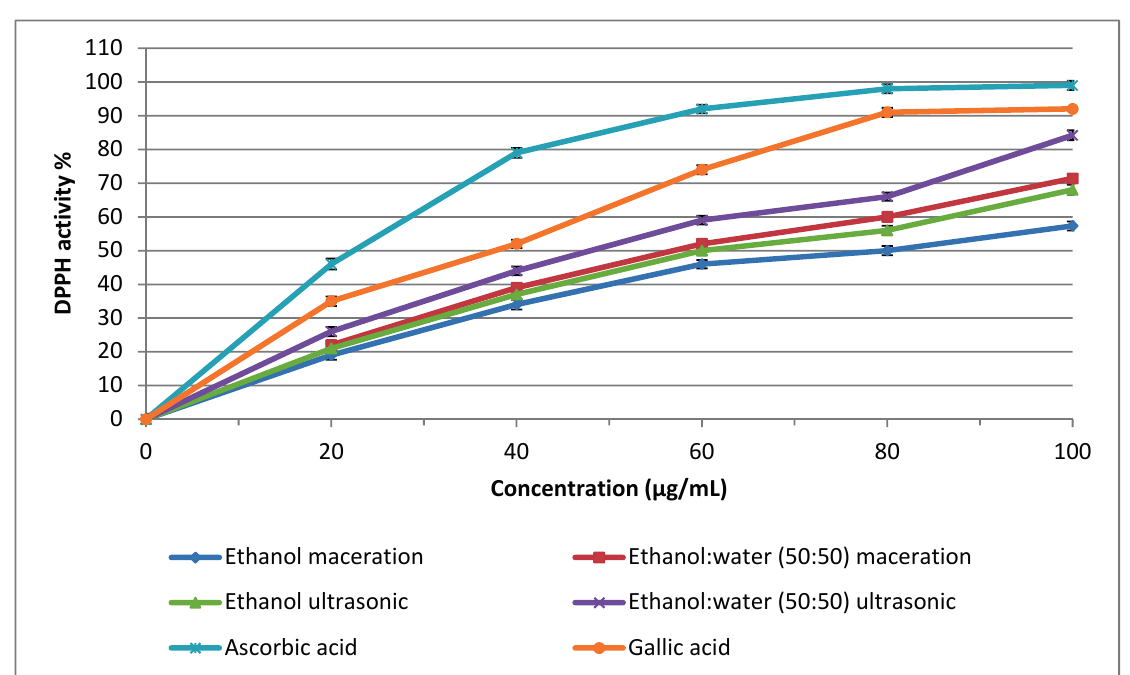
Figure 1. Free radical scaven rice bran. Error bars represent standard errors of the mean ( n =